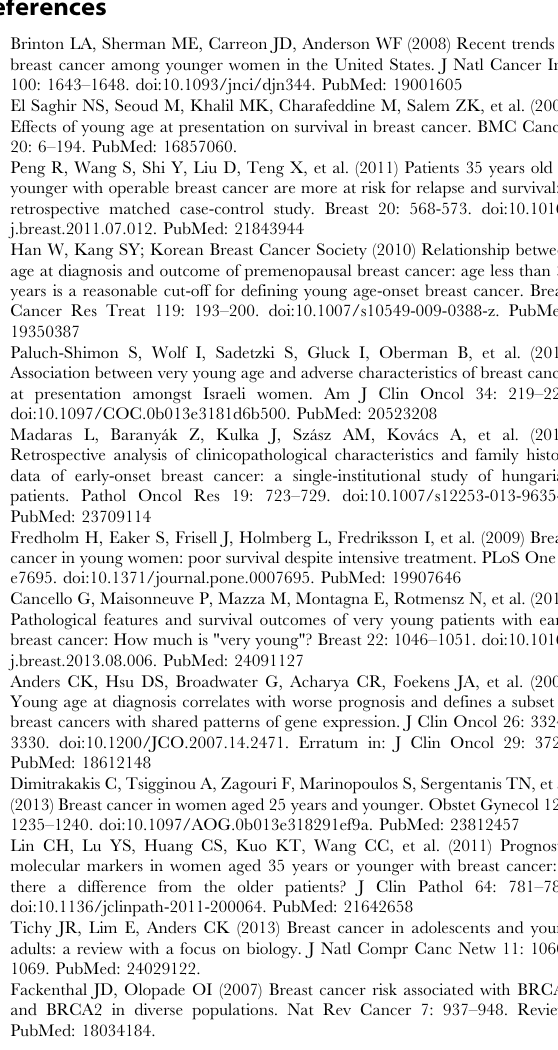
Table S5 miR–mRNA not predicted interactions, pre- senting inverse correlation. Table S6 Biological processes. Categories over represented by the target genes related to 49 miR-mRNA interactions. Table S7 Patient and tumor characteristics of the validation